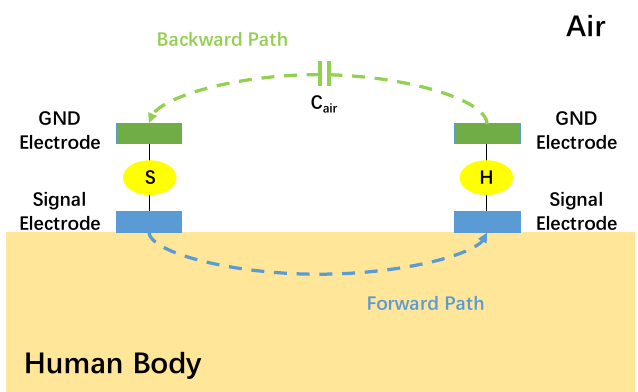
Figure 2. System block diagram of body channel wireless power transfer (BC-WPT) [17]. GND =